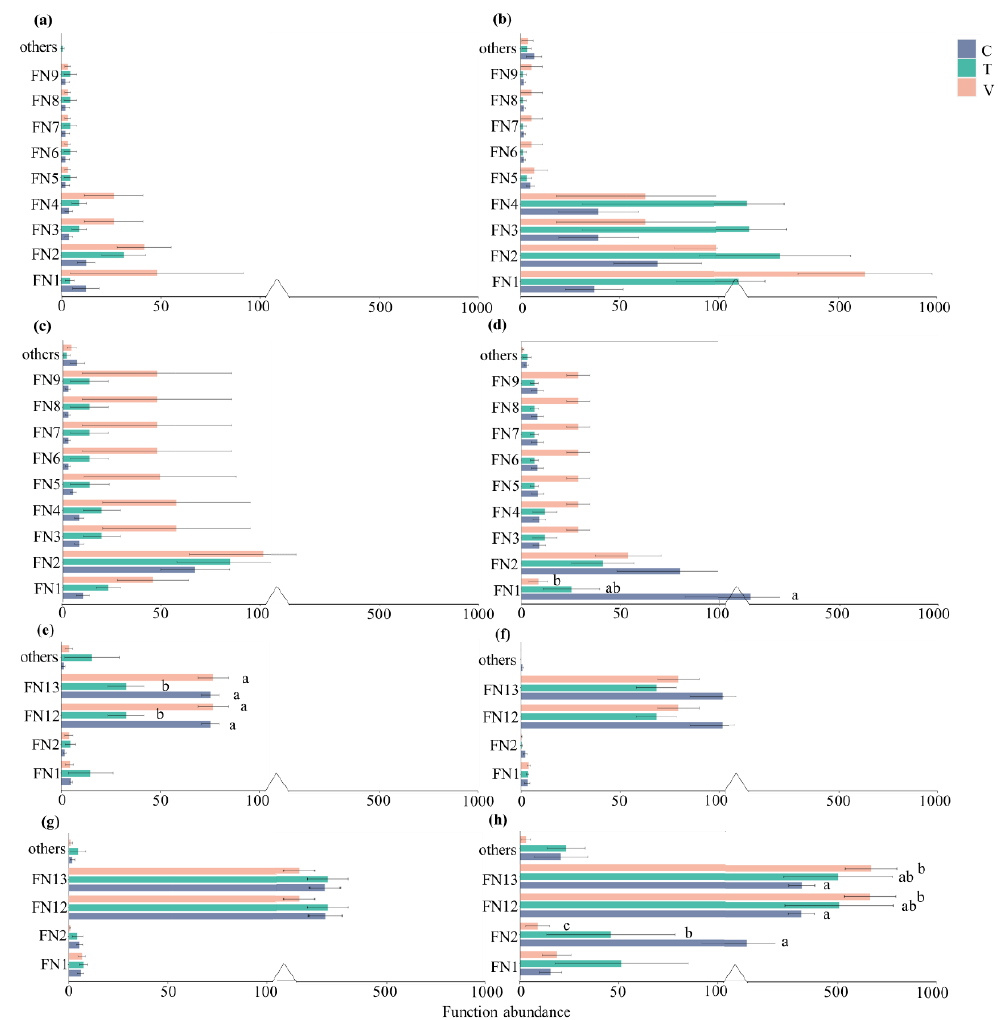
Figure 5. Columnar difference in bacterial function related to the nitrogen cycle in water column and sediment. All data are presented as the mean ± SE. The letters above the bars represent significant differences between treatments ( p < 0.05). ( a ), Nitrogen cycle of water in spring; ( b ), Nitrogen cycle of water in summer; ( c ), Nitrogen cycle of water in autumn; ( d ), Nitrogen cycle of water in winter; ( e ), Nitrogen cycle of sediment in spring; ( f ), Nitrogen cycle of sediment in summer; ( g ), Nitrogen cycle of sediment in autumn; ( h ), Nitrogen cycle of sediment in winter. The nitrogen cycle in the figure is represented by FN1-FN13, and the specific functions are nitrogen fixation (FN1), nitrate reduction (FN2), nitrate respiration (FN3), nitrogen respiration (FN4), nitrite respiration (FN5), nitrate denitrification (FN6), nitrite denitrification (FN7), nitrous oxide denitrification (FN8), denitrification (FN9), nitrate ammonification (FN10), aerobic nitrite oxidation (FN12), and nitrification